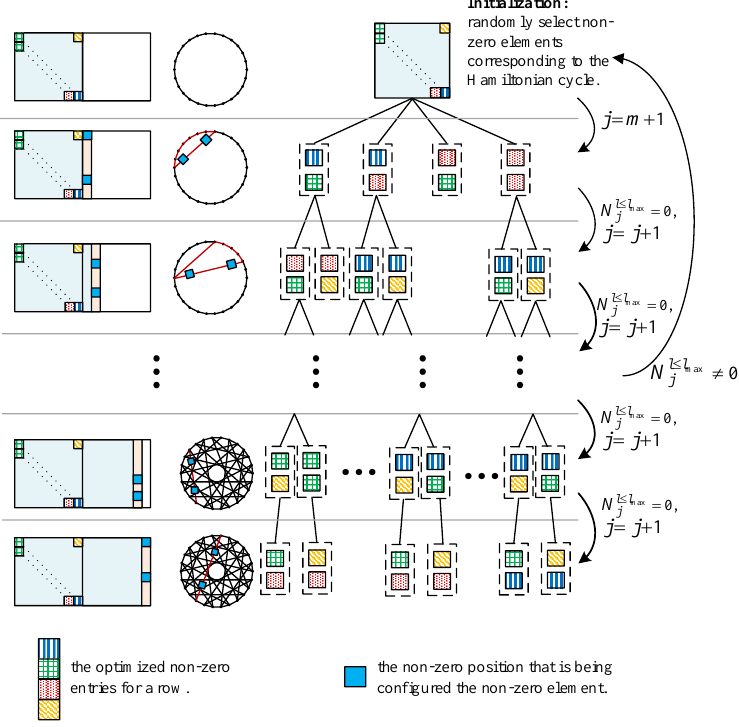
Figure 4. The scheme of configuring non-zero entries based on the progressive chord edge